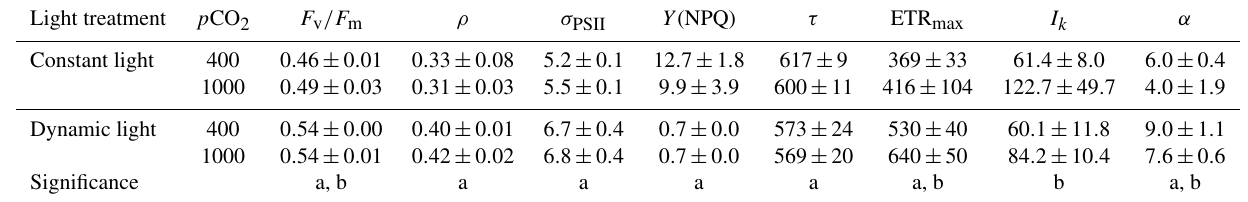
Table 3. FRRf-based photophysiological parameters for M. pusilla ( n = 4; mean ± 1 SD). Displayed is the F v /F m (dimensionless), the connectivity between PSIIs ( ρ ; dimensionless), the absorption cross section of PSII photochemistry ( σ PSII ; Å 2 · q − 1 ), the non- photochemical quenching ( Y (NPQ); dimensionless), the PSII reopening rate ( τ ; ms), the maximum photosynthetic rate (ETR max ; mole − (molRCII) − 1 s − 1 ), the light harvesting efficiency ( α ; mole − m 2 (molRCII) − 1 (molphotons) − 1 ) and the light saturation constant ( I k ; µmolphotonsm − 2 s − 1 ) for both light regimes and p CO 2 levels (µatm). The letters indicate significant differences between treatments ( p < 0 . 05) represented as (a) light and (b) p CO 2 . Light treatment p CO 2 F v /F m ρ σ PSII Y (NPQ) τ ETR max Constant light 400 0 . 46 ± 0 . 01 0 . 33 ± 0 . 08 Dynamic